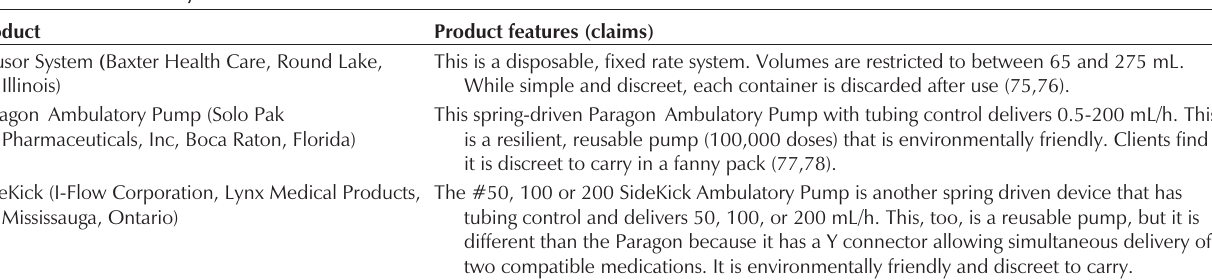
Nonelectronic delivery device Product Product features (claims)